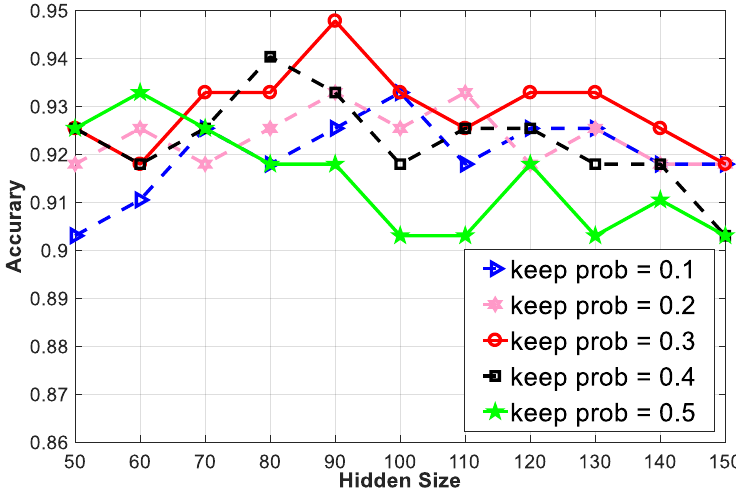
Figure 6. Impact of hyper-parameters.